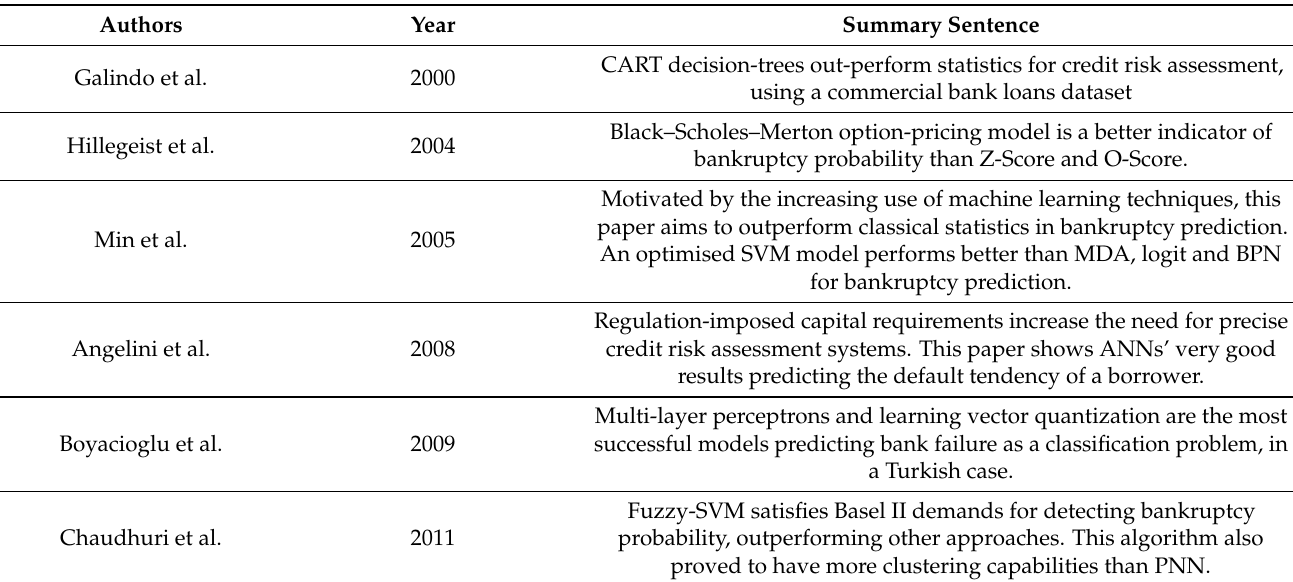
Table 1. Short summary of each analysed paper, referenced by authors and